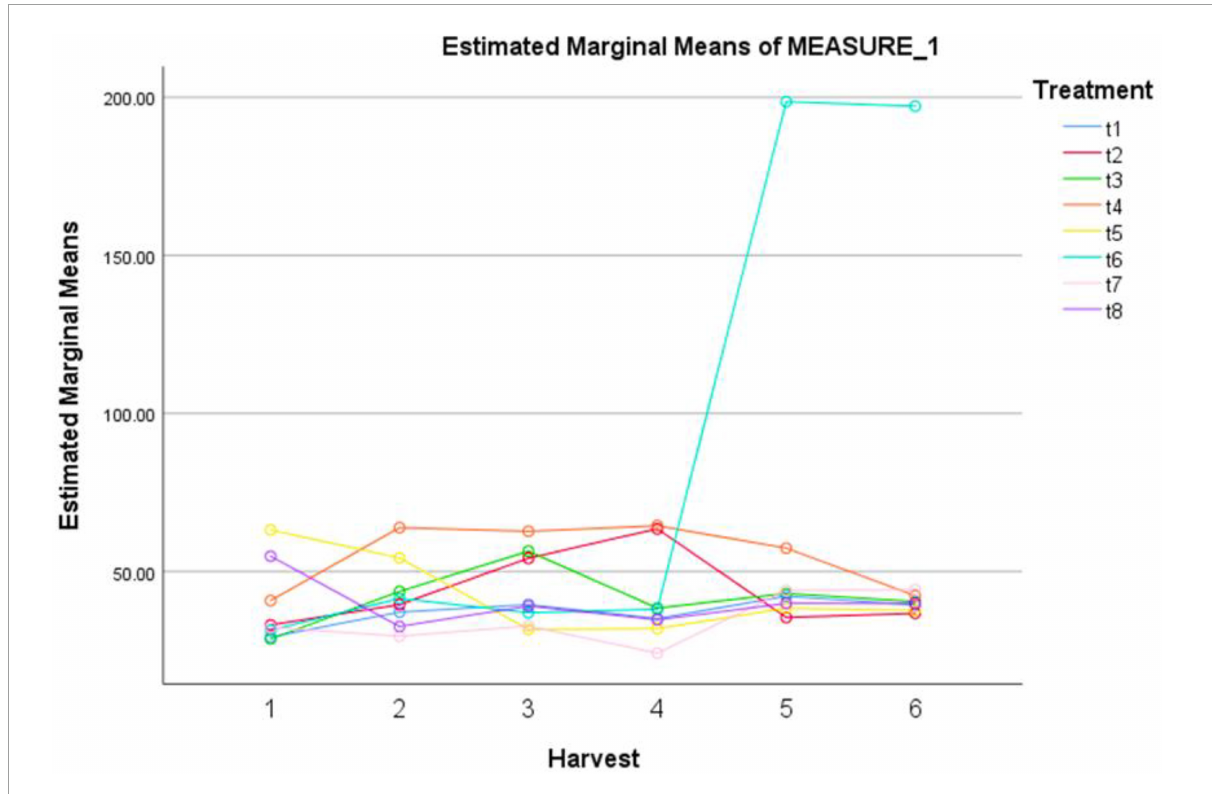
FIGURE4 Effect of different treatments of elicitors on nitric oxide levels of Silybum marianum in hydroponics. The harvest time is on x -axis; 1 = 24 h, 2 = 48 h, 3 = 72 h, 4 = 96 h, 5 = 120 h, 6 = 144 h. For different treatments, t1 = control, t2 = methyl jasmonate, t3 = silver nanoparticles, t4 = fungal elicitors, t5 = methyl jasmonate + fungal elicitors, t6 = methyl jasmonate + silver nanoparticles, t7 = fungal elicitors + Silver nanoparticles, t8 = methyl jasmonate + silver nanoparticles + fungal